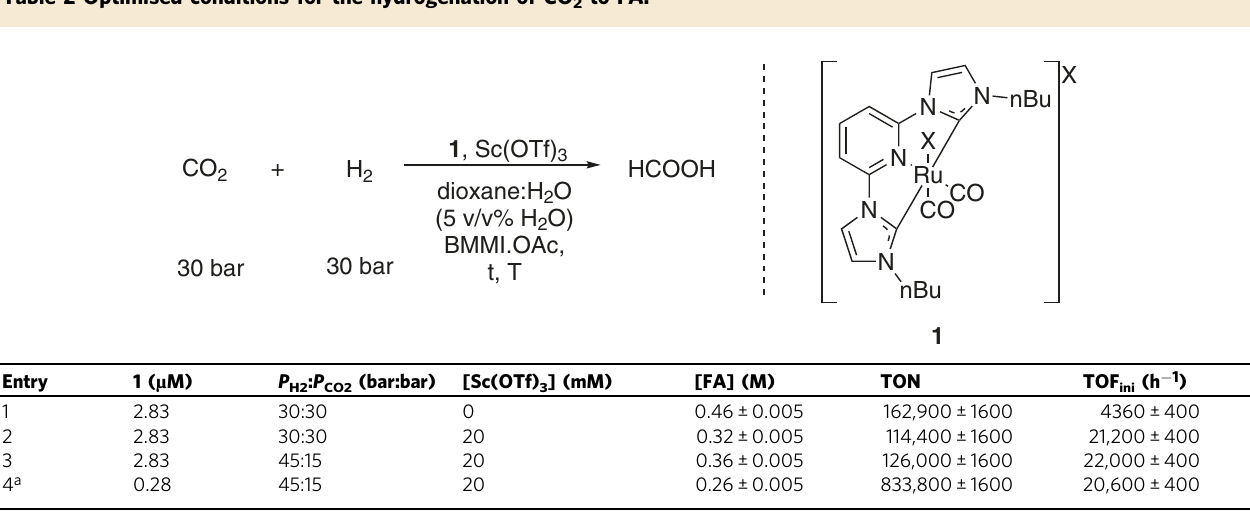
Table 2 Optimised conditions for the hydrogenation of CO 2 to